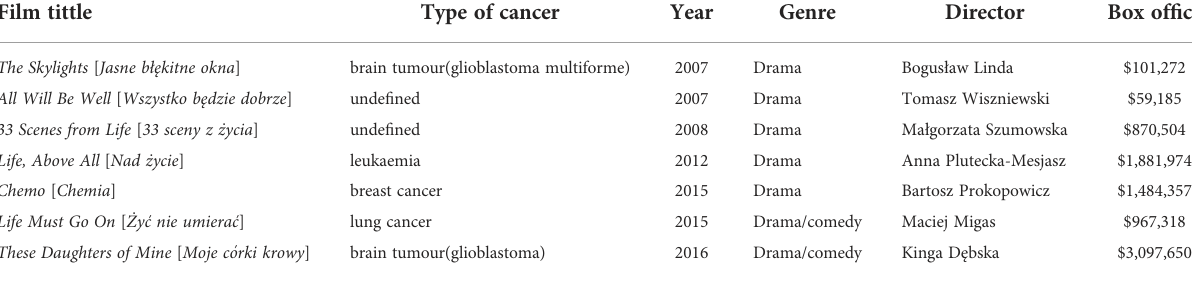
TABLE 1 List of selected fi lms (N=7). Film